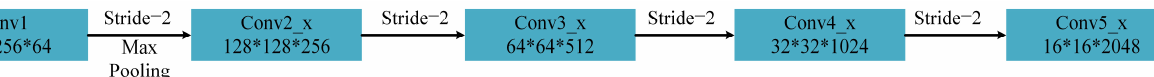
Figure 4. The structure of the baseline feature extractor.